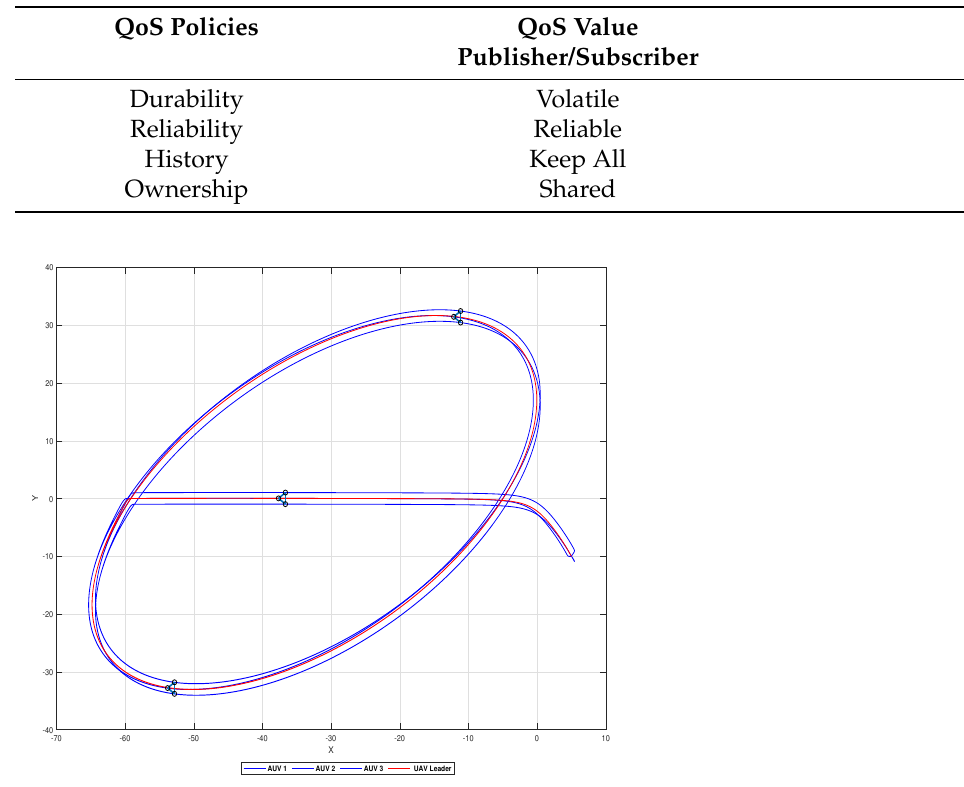
Figure 2. The formation control of three AUVs in triangle formation with their UAVs leader without disturbance and uncertainty in 2D space.